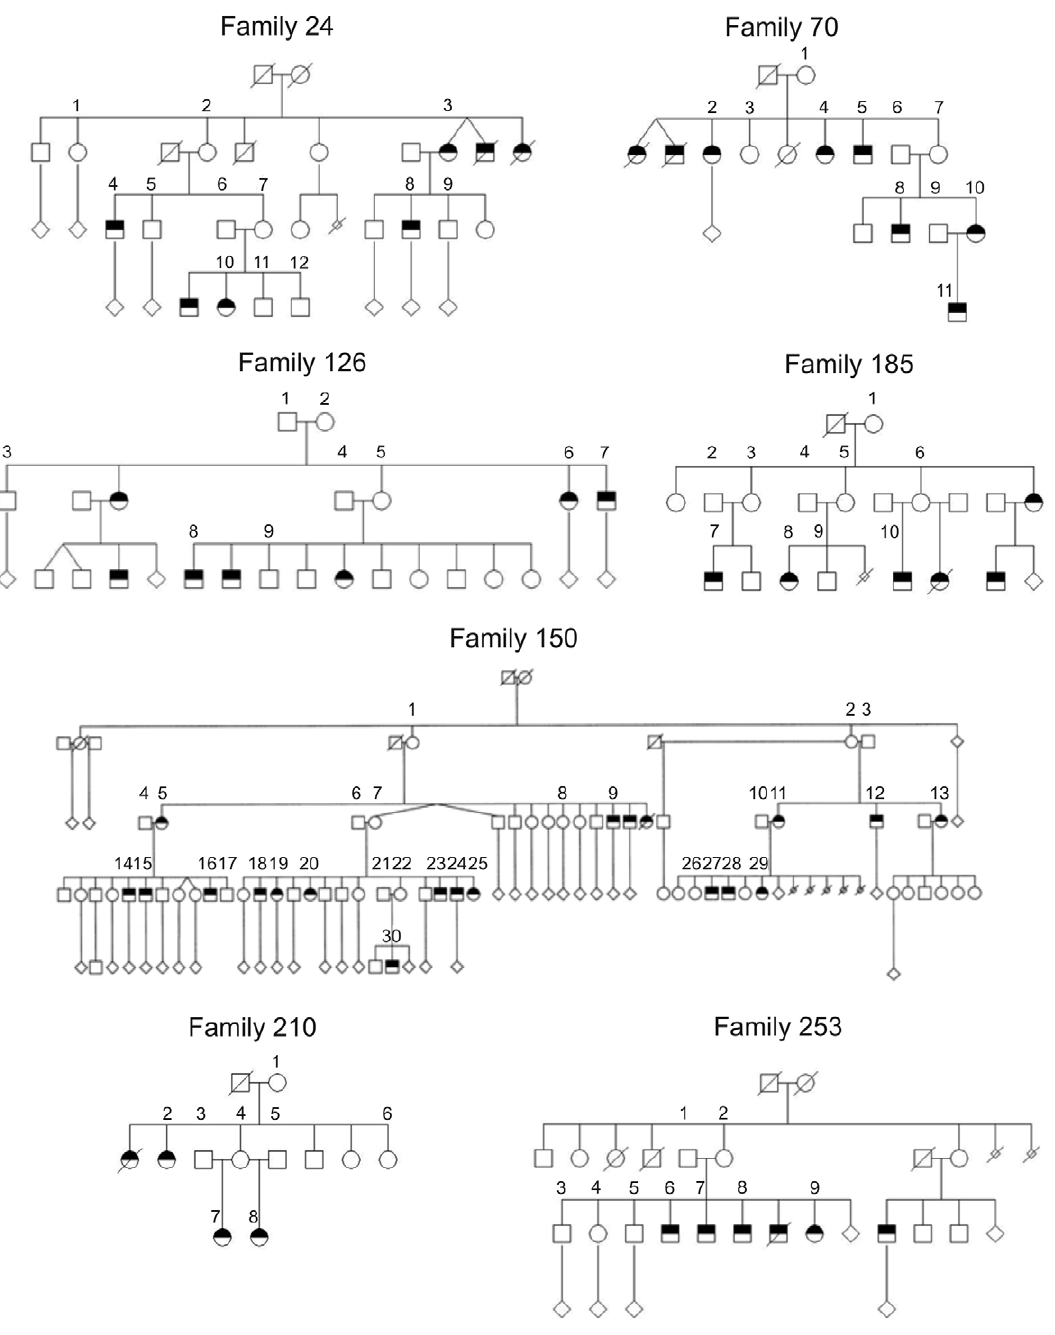
Figure 1. Pedigrees of the seven families with recurrent spontaneous preterm births analyzed in the linkage analysis of X chromosomal markers. Individuals born preterm are shown by half-black symbols. Squares represent males and circles females. Individuals analyzed in the linkage analysis are indicated by a number ( n =89). The diamonds denote an unspecified number of term infants, the smaller diamonds with a line through the symbol represent a miscarriage, and the lines through the other symbols indicate that the person is deceased. Gestational ages and years of birth for the family members born preterm are shown in Table S1. Linkage analysis was performed in two settings: 1) being spontaneously born preterm as the phenotype (affected offspring phenotype, n affected =41), and 2) giving spontaneous preterm births as the phenotype (affected mother phenotype, n affected =21). These pedigrees have been previously shown in the supplementary material of our linkage study of SPTB performed using autosomal markers [27]. a risk factor for preterm birth [4]; 22 individuals selected using this compared to female fetuses [30]; 8 individuals selected using this criterion). None of the SPTB cases were members of any of the criterion). If these criteria were not applicable, a female individual was selected over a male individual (criterion applied because a linkage analysis families. The clinical characteristics of the case somewhat higher proportion of male fetuses are born preterm study population are shown in Table 1. Whole-blood or buccal